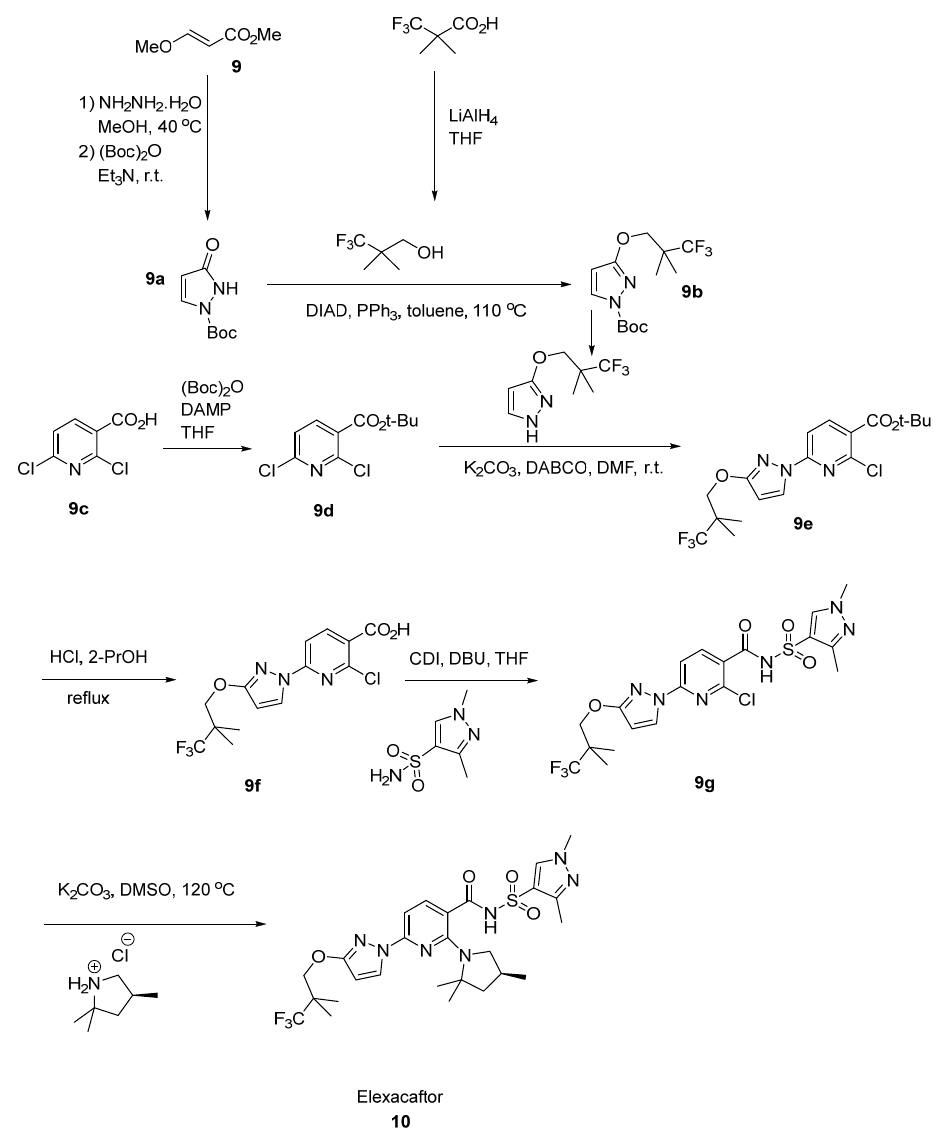
Figure 5. Synthesis and structure of elexacaftor.